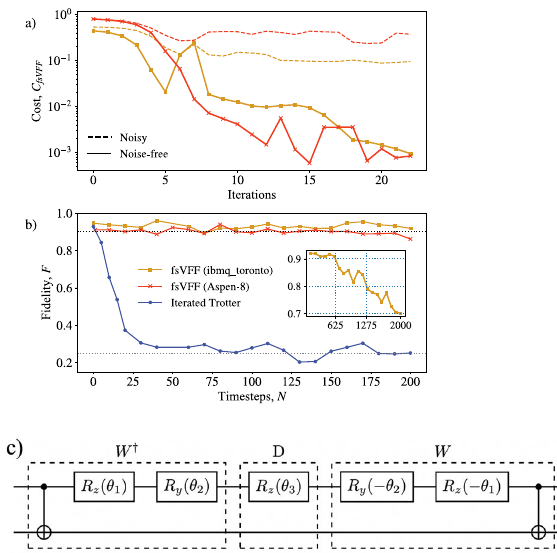
Fig. 3 Hardware Implementation. a The 2-qubit parameterized quantum circuit shown in c was trained to diagonalize U ( Δ t ), a fi rst order Trotter expansion of the 2-qubit XY Hamiltonian with Δ t = 0.5, in the subspace spanned by 10 j i and its future evolution. The dashed line plots the noisy cost as measured on ibmq_toronto (yellow) and Aspen-8 (red) using 30,000 samples per circuit. The solid line indicates the equivalent noise-free cost that was calculated on a classical simulator. b The initial state ψ 0 j i ¼ 10 j i is evolved algorithm for determining n eig on the states 00 j i (corresponding forwards in time on the ibmq_rome quantum computer using the to n eig = 1), 10 j i ( n eig = 2) and 1 ffiffi p ð 00 j i þ 10 j iÞ ( n eig = 3). As 2 iterated Trotter method (blue) and using fsVFF with the optimum described in Section “ Calculating n parameters found on ibmq_toronto (yellow) and Aspen-8 (red). The quality of the simulation is evaluated by plotting the fi delity F ¼ ψ h j ρ ψ j i between the evolved state and exact evolution. The gray dotted line at F = 0.25 represents the overlap with the maximally mixed state. The black dotted line denotes a threshold fi delity at F = 0.9. The inset shows the fast-forwarding of the ansatz trained on ibmq_toronto on a longer timescale, where the fi delity dropped below 0.9 (0.8) at 625 (1275) timesteps. All simulation data was taken using 8192 samples per circuit. c The ansatz used to diagonalize the 2-qubit XY Hamiltonian in the subspace of initial state 10 j i for the implementation on Rigetti and IBM ’ s quantum computers. Here